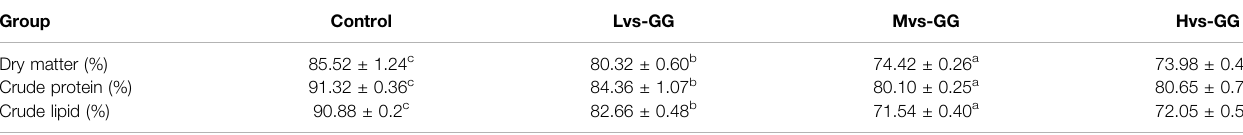
TABLE 5 | Effects of different viscous guar gum on nutrient apparent digestibility of juvenile largemouth bass. Group